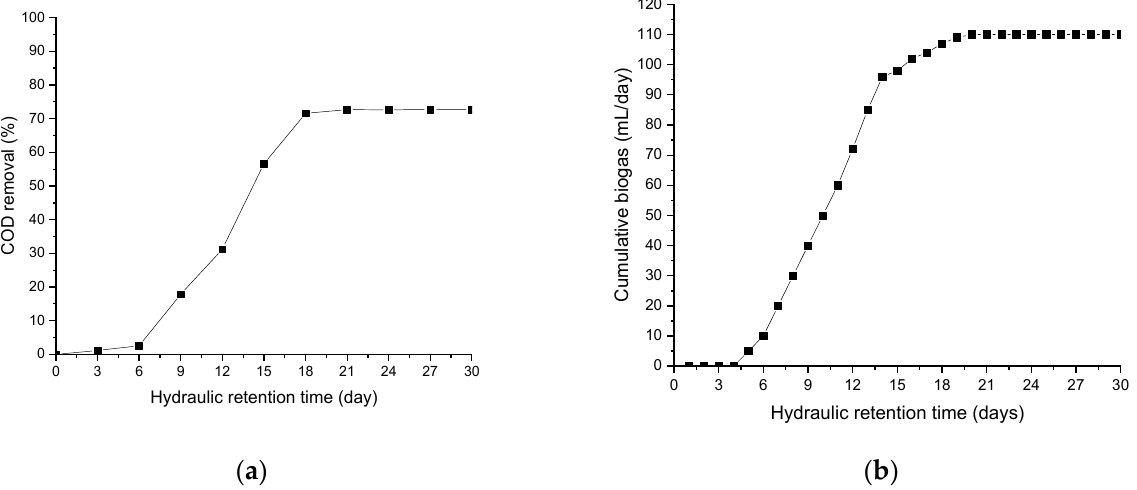
Figure 2. Effect of hydraulic retention time on ( a ) cumulative biogas generation; ( b ) degradation of chemical oxygen demand (COD).